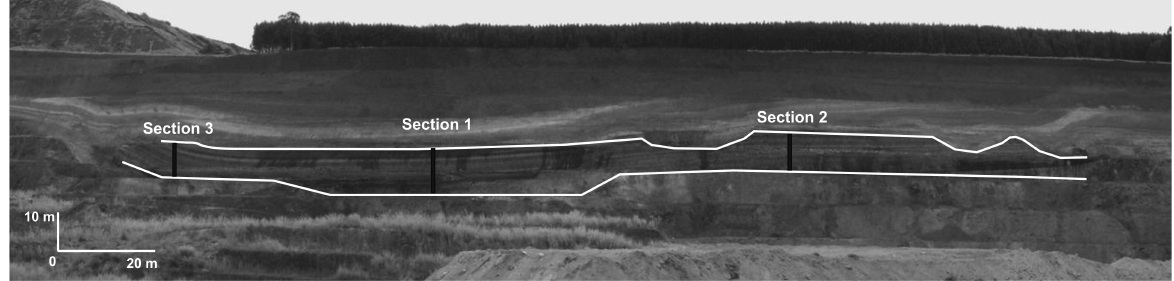
Fig. 2. Photograph of the Cemitério Paleolake. The white line traces the limits of the deposit. The black bars indicate the position of the three sampled